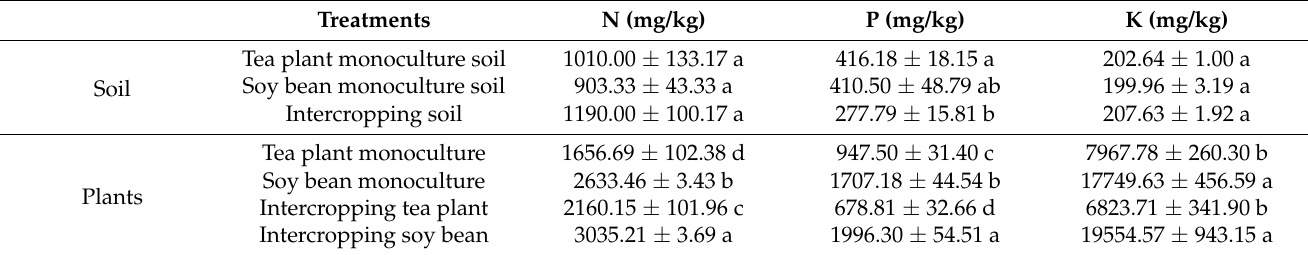
Table 1. Effect of tea plant/soybean intercropping on the content of N, P, and K in soil and whole tea plants. All data are shown as the mean ± SD ( n = 3). Data following same letters were not significantly different at p < 0.05.